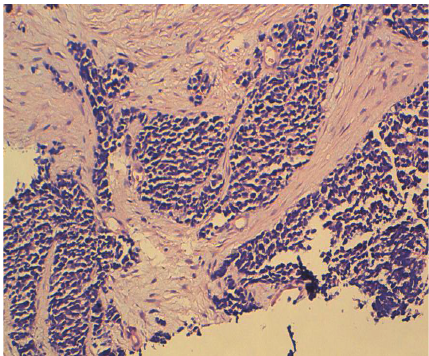
Figure 5: CT-scan-guided TCB slide of a pancreatic mass in a 56 year-old man: cytomorphological features at higher magnification view: small, round tumor cells with scanty cytoplasm, which showed extensive nuclear molding. The nuclei of the tumor cells were round to oval and had salt and pepper type chromatin pattern.